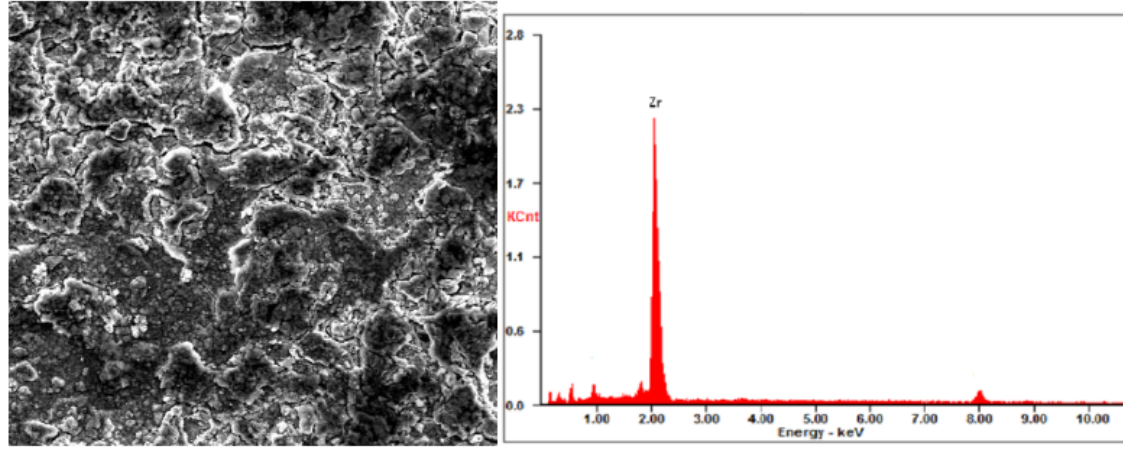
Figure 6: EDS of Zr electrodeposited layer